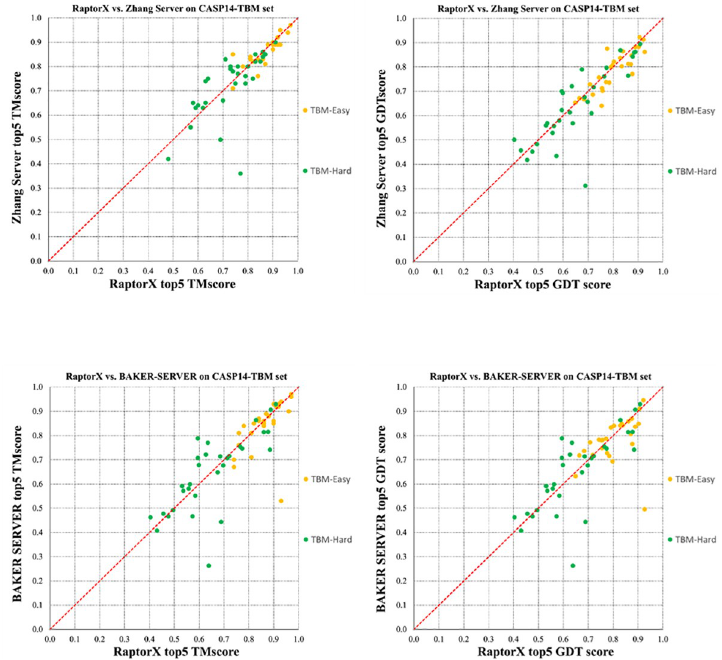
Fig 6. The head-to-head comparison between RaptorX, Zhang-Server, BAKER-RosettaServer on the CASP14 TBM targets. The best of top 5 models are evaluated. Top left: RaptorX vs. Zhang-Server in terms of TMscore. Top right: RaptorX vs. Zhang-Server by GDT. Bottom left: RaptorX vs. RosettaServer by TMscore. Bottom right: RaptorX vs. RosettaServer by GDT. Each point represents two 3D models generated by two competing methods. GDT is scaled to [0,